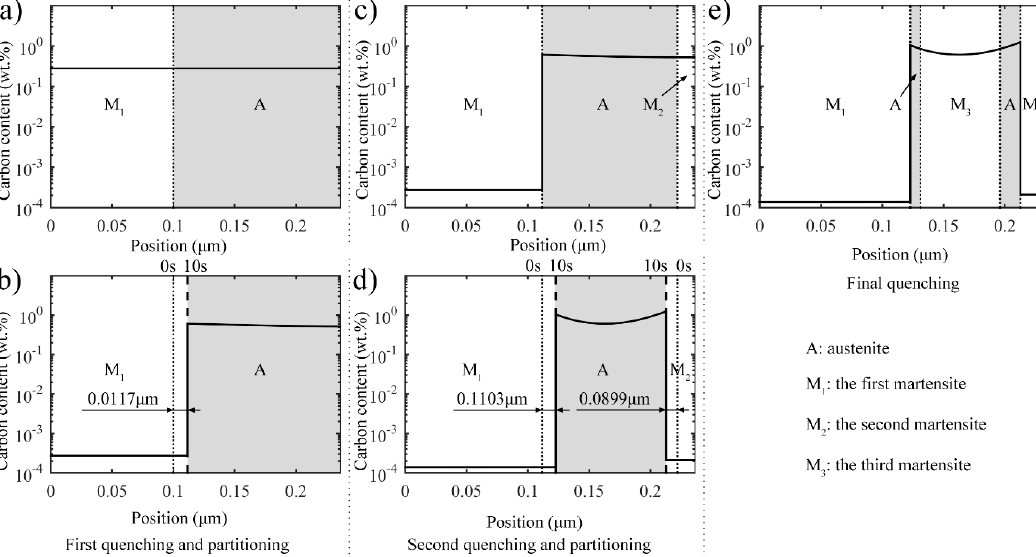
Figure 2. Microstructure and carbon diffusion in different stages of the two-stage Q-P process: ( a ) quenching the steel to the first quenching temperature 325 °C; ( b ) holding the steel at 425 °C for 10 s to achieve incomplete partitioning; ( c ) quenching the steel to the second quenching temperature 250 °C; ( d ) conducting another incomplete partitioning at 350 °C for 10 s; ( e ) quenching the steel to room temperature. The shadow represents austenite, and the distance in the figure marks the interface migration during both partitioning processes.